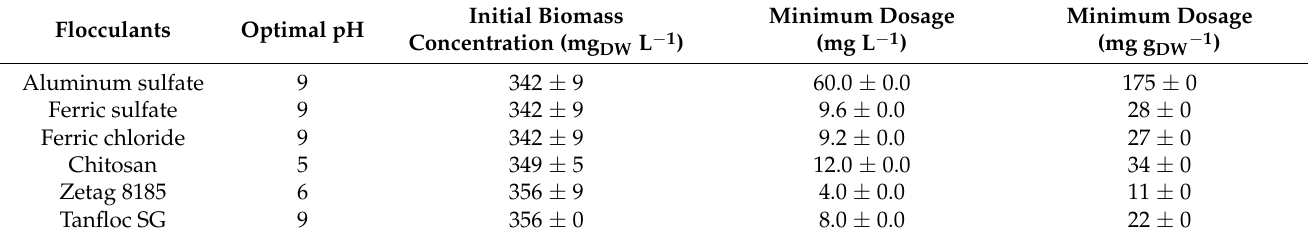
Table 2. Optimal pH and minimum dosage for flocculation obtained for aluminum sulfate, ferric sulfate, ferric chloride, chitosan, Zetag 8185, and Tanfloc